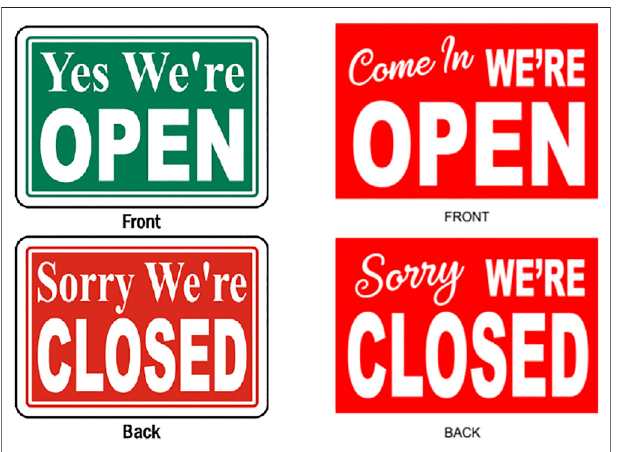
FIGURE 7 | Two examples of Open/Closed signs.